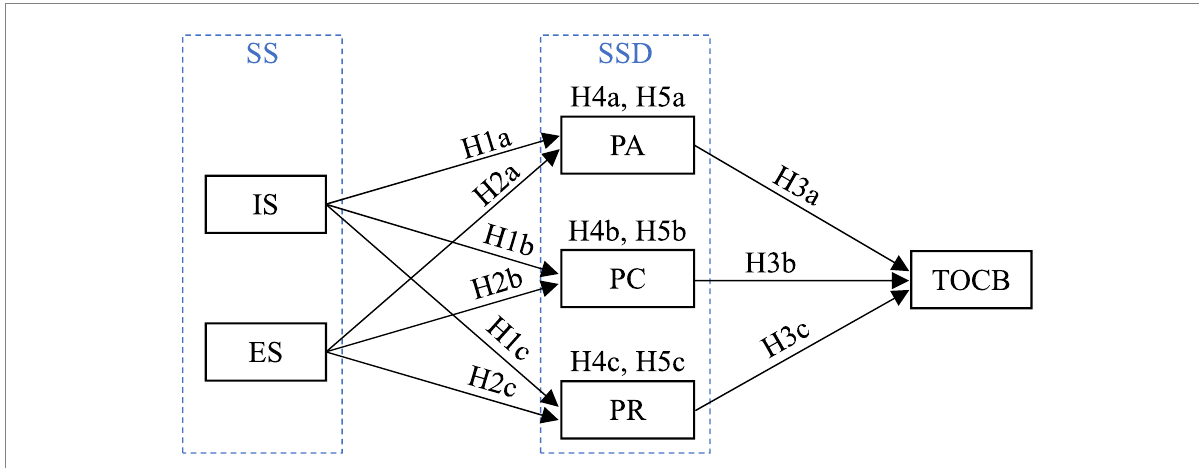
FIGURE 1 Conceptual framework. (1) SS, social support; SSD, the sense of self-determination; IS, information support; ES, emotional support; PA, perceived autonomy; PC, perceived competence; PR, perceived relatedness; TOCB, tourist-oriented citizenship behavior. (2) H4a: IS → PA → TOCB; H4b: IS → PC → TOCB; H4c: IS → PA → TOCB; H5a: ES → PA → TOCB; H5b: ES → PC → TOCB; H5c: ES → PA →